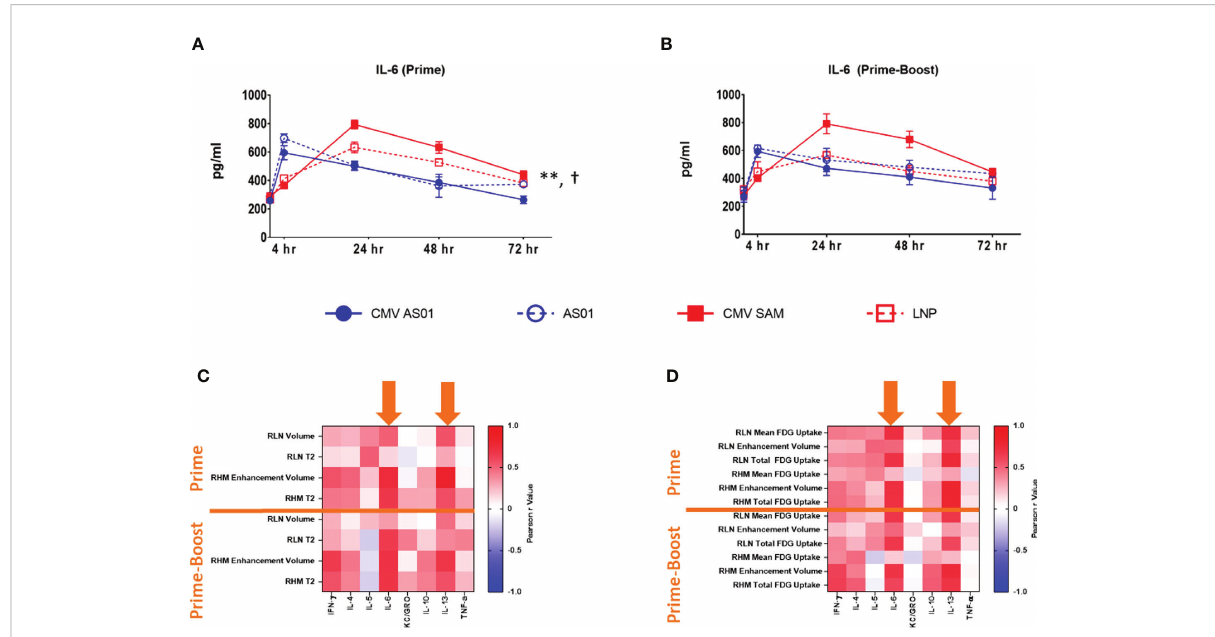
FIGURE 5 Cytokine correlation with MRI and PET imaging endpoints. Plasma IL-6 temporal response following Prime (A) and Prime-Boost (B) vaccine injection. Heat map of Pearson correlations between plasma cytokine/chemokines and MRI (C) and 18 FDG PET (D) endpoints in right hindlimb muscles (RHM) and right lymph node (RLN) following Prime and Prime-Boost vaccine injection. Orange arrows indicate strong correlations between IL-6 and IL-13 with MRI and 18 FDG PET endpoints. Data are presented as mean ± SEM. **P<0.01 CMV SAM AUC vs CMV AS01 AUC; † P<0.01 CMV SAM maximum vs CMV AS01